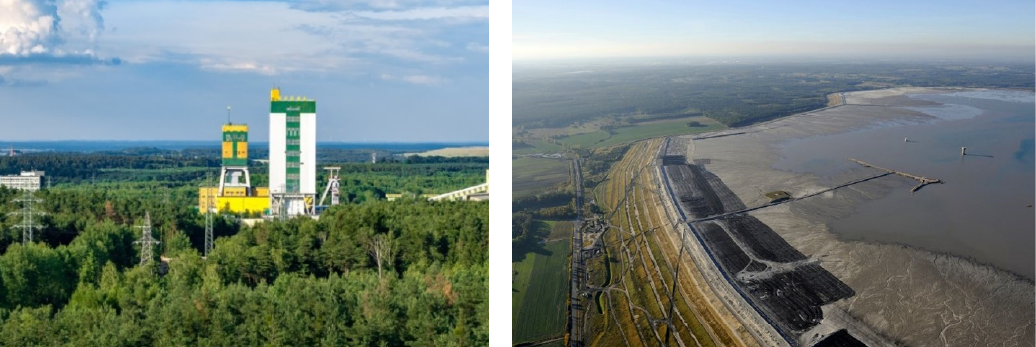
Figure 2. Left —Rudna-I Shaft of the Rudna copper mine, and right —the slope of Zelazny Most storage facility.